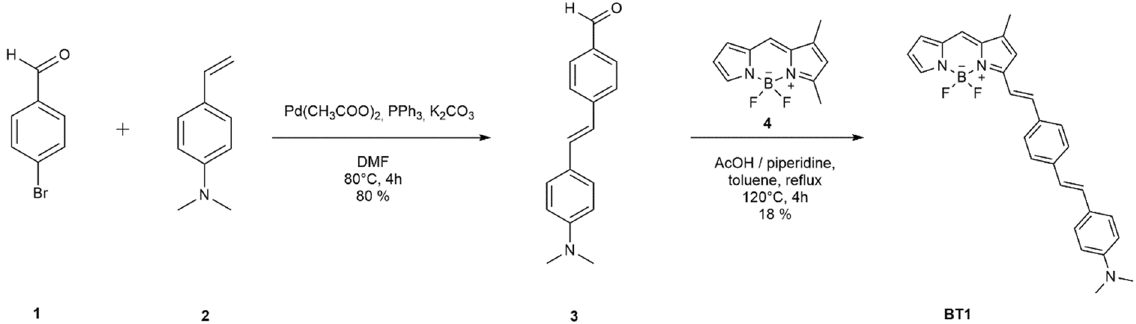
Figure 2. Two-step synthetic strategy for the preparation of BT1. (ChemDraw software version 20.1.0.112 (112); PerkinElmer and Fig. S19). As shown in Fig. 3B, the fluorescence spectra of BT1 in the presence of preincubated tau fibrils displayed a strong enhancement at 565 nm indicating the BT1 binding to fibrillated tau. Parallel experiments were conducted monitoring BT1 fluorescence in the presence of BSA under experimental conditions known to induce the formation of BSA aggregates, characterized by the formation of β-sheet structures 45,46 . As reported in Fig. 3C BT1 fluorescence spectra did not significantly change over time in the presence of fibrillated BSA, thus indicating the selectivity of the BT1 probe for tau fibrils . Validation of human‑induced pluripotent cell line WT#1 and neuronal differentiation. An in- house iPSC line named WT#1 (Supplementary Fig. S17) 47,48 was used for assessing the detection efficiency of tau aggregates by BT1 compound. The iPSC line WT#1 carries the doxycycline-inducible NGN2 cassette into the safe harbor AAVS1 locus 49 . NGN2-engineered iPSCs were treated for 4 days with 2 ug/mL doxycycline for inducing the rapid overexpression of the human NGN2 gene which is recognized as a potent molecular factor capable to drive the differentiation towards a neurocortical fate and specifically towards excitatory cortical neu- rons (Fig. 4A, B). To confirm the proper differentiation of WT#1 line into neuronal cells after 30 days in culture (Fig. 4C), a time-course quantification by real-time PCR of the key neuronal molecular markers was performed. As expected, a steep increase of NGN2 transcript was found in the first week of culture as a consequence of the doxycycline FOXG1, TUJ1, MAP2. Excitatory synaptic transcripts (SYN and vGLUT1) arose in a time-dependent fashion between day 15 and day 30, suggesting the establishment of a mature neuronal network at later time points. At